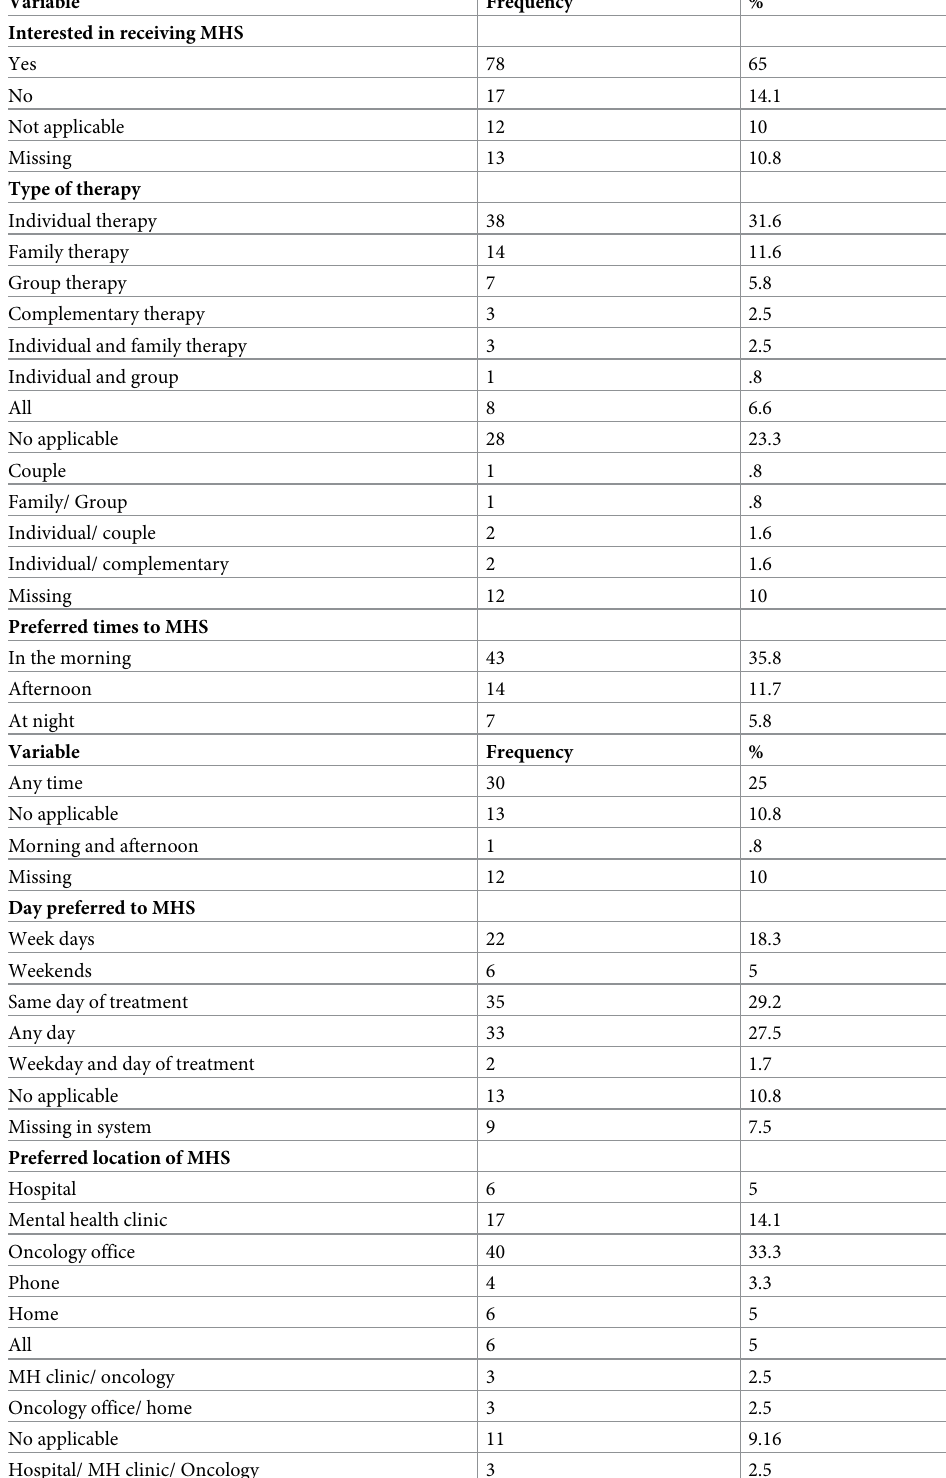
Table 3. Mental health service (MHS) preference (n =